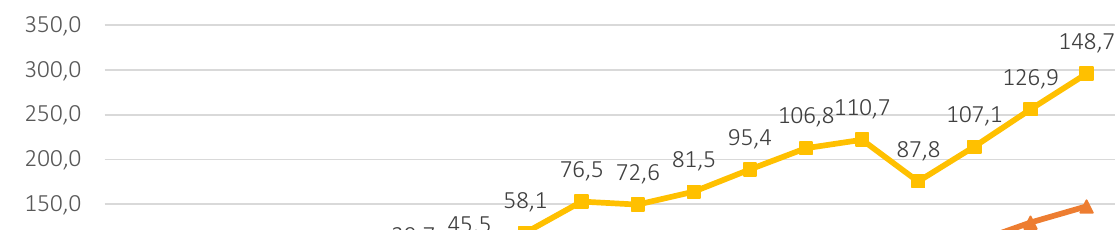
Source: Developed by the